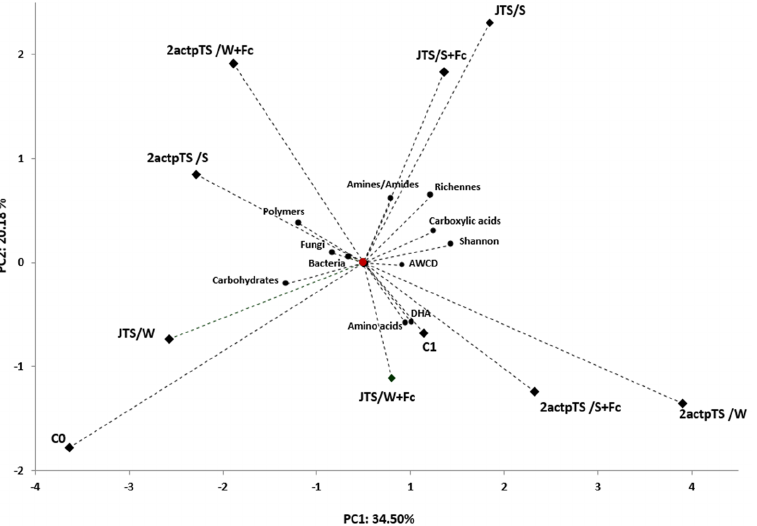
Figure 5. Hierarchical dendrogram of samples using Ward’s clustering method with bond dis- tances. Boundaries of Sneath’s criteria, restrictive (33%) and less restrictive (66%), are marked on the dendrogram.